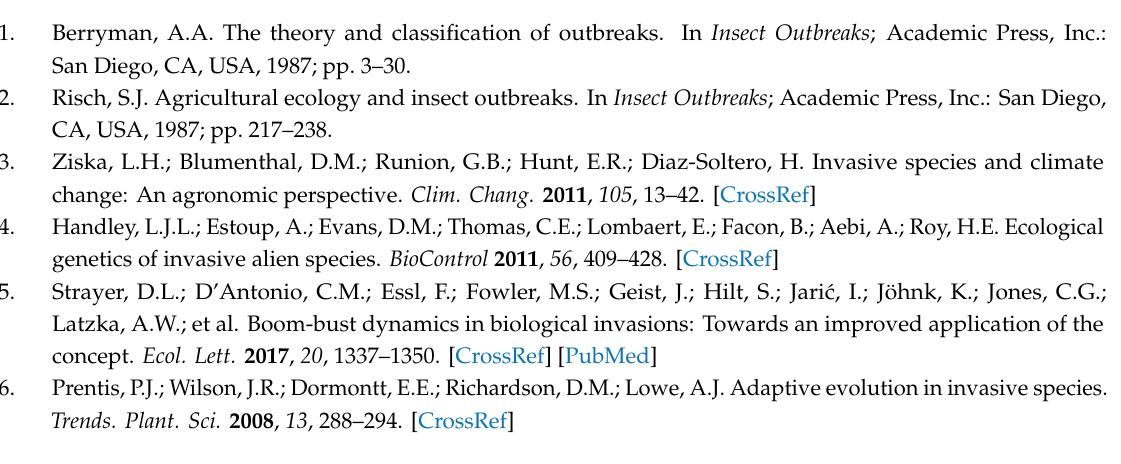
Figure S1: Phylogeny of the outbreak Aspidiotus rigidus populations in the Philippines based on mtCOI and EF-1 α Table S1: Summary of the computations of the parameters for demographic expansion for the EF-1 α dataset, Table S2: Population pairwise F ST values between the outbreak A. rigidus populations for mtCOI and EF-1 α data, Table S3: Bayes factors and log marginal